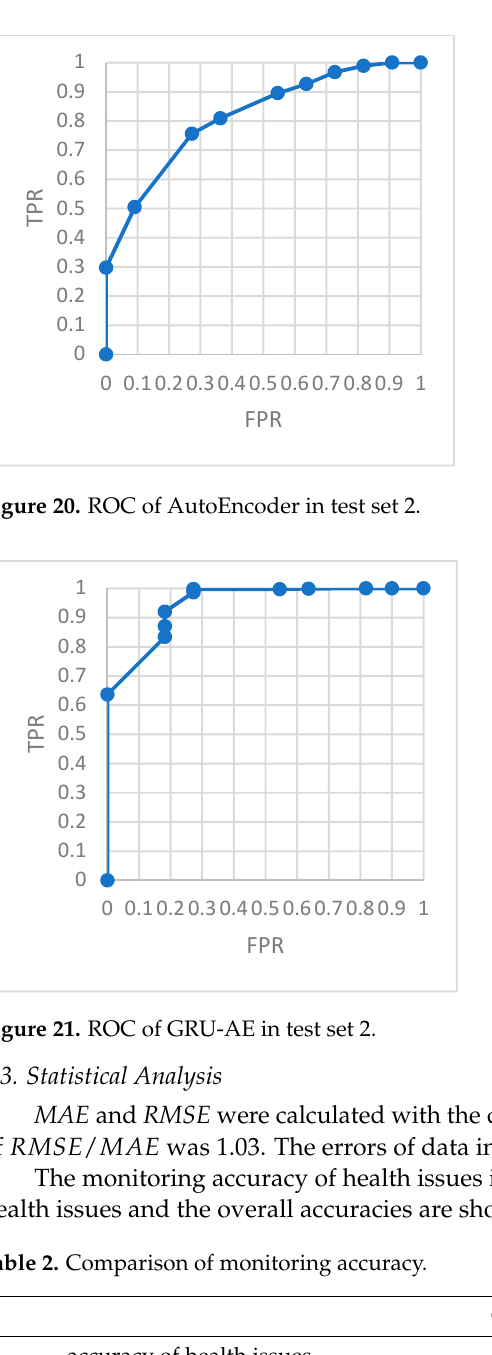
Figure 19. ROC of GRU-AE in test set 1.